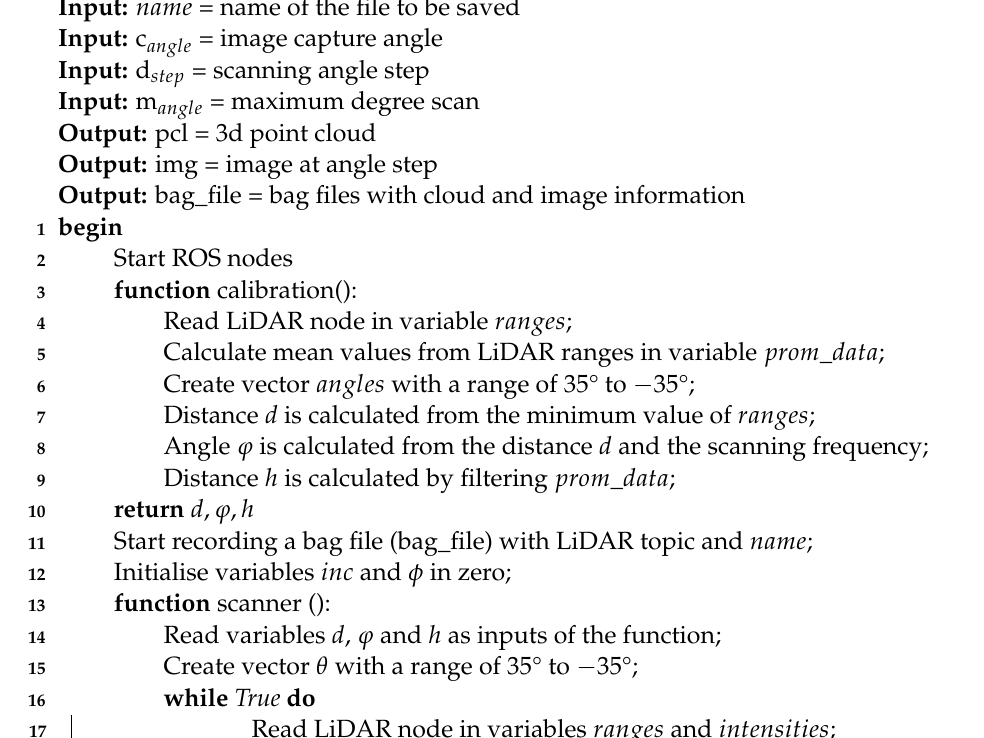
Algorithm 1: 3D model generation with the proposed LiDAR scanning